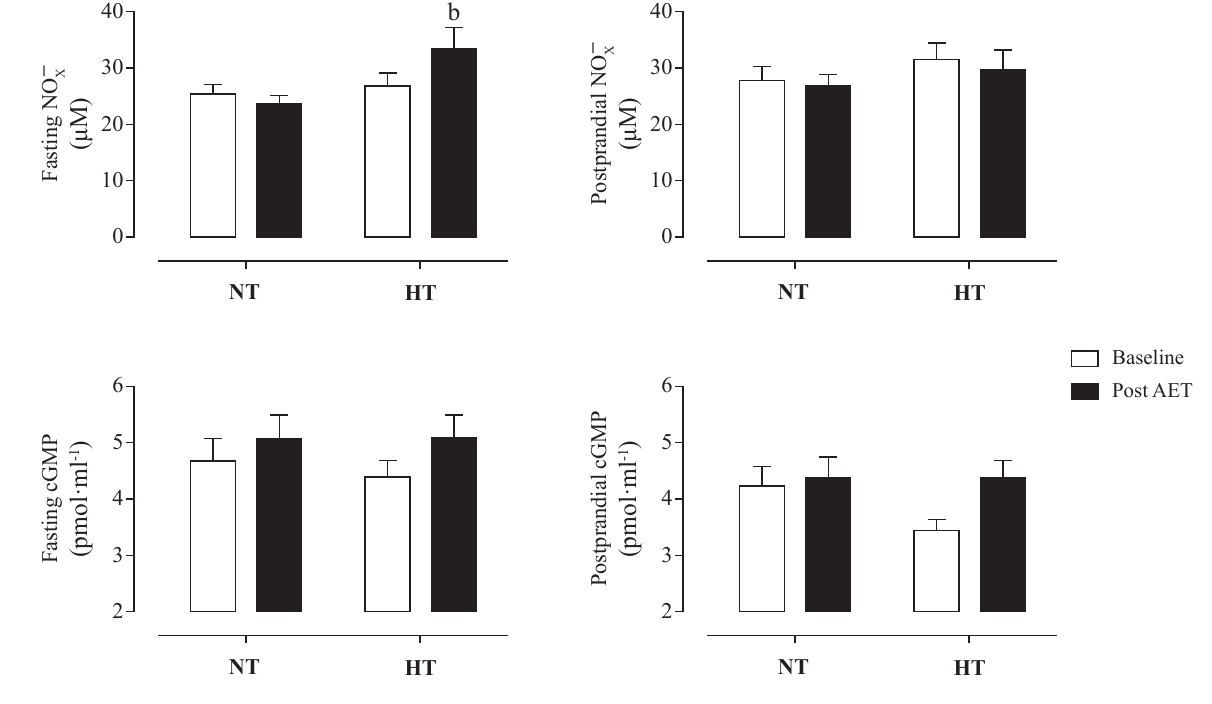
Figure 2.Effects of aerobic exercise training on NOx- and cGMP in normotensive and hypertensive postmenopausal women at baseline and post aerobic exercise training.